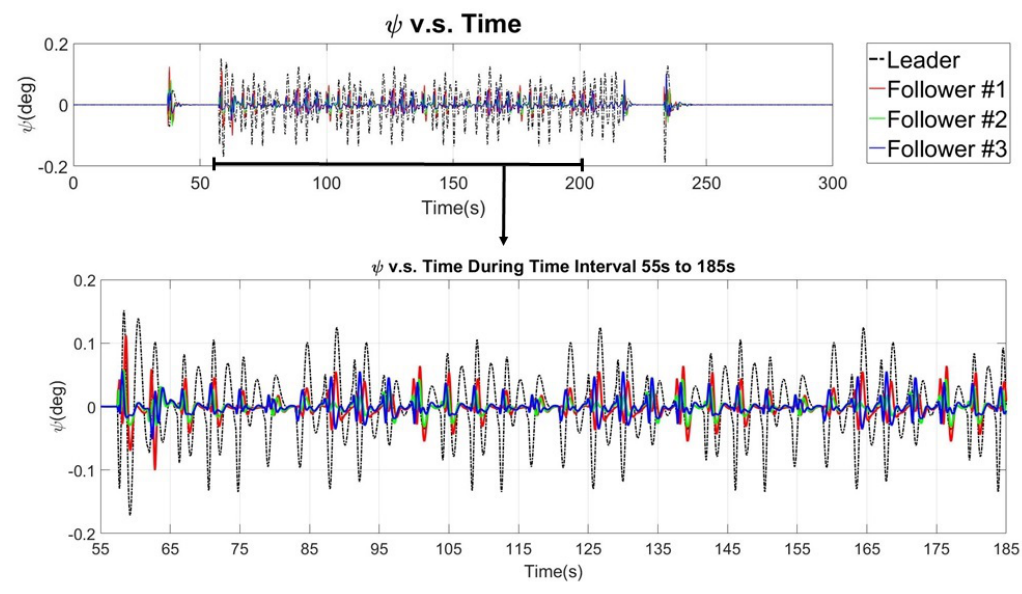
Figure 18. Quadrotor yaw angle throughout the comprehensive